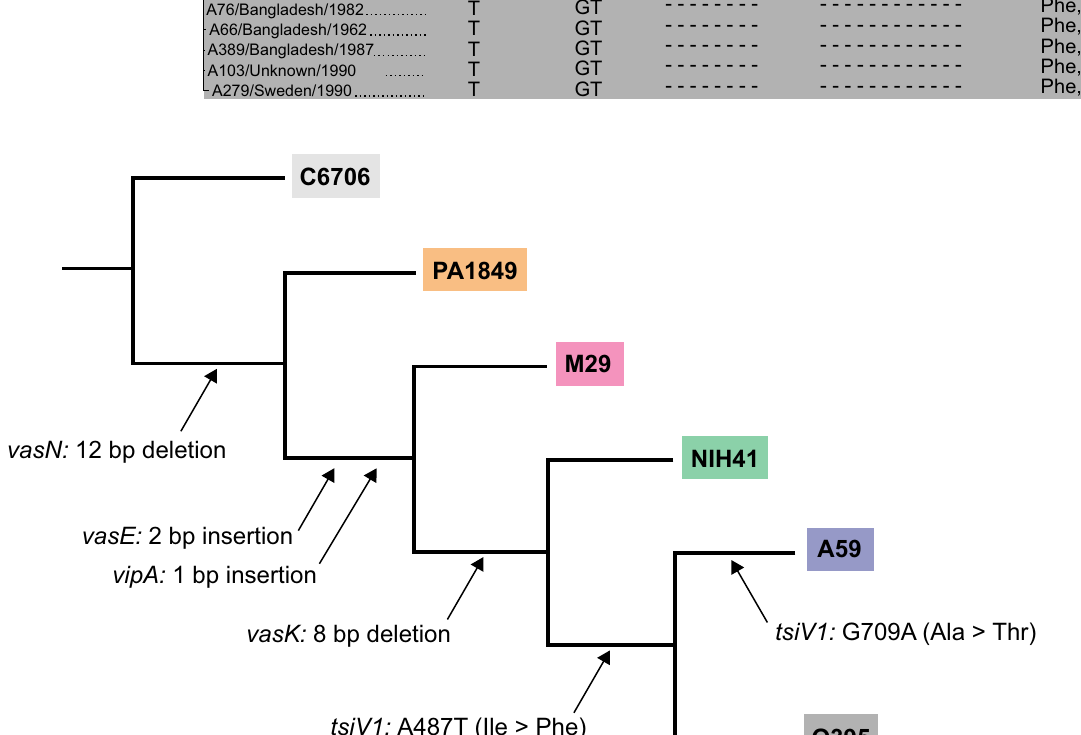
Fig. 4 Phylogeny of V. cholerae strains and their T6SS gene clusters. A Maximum likelihood tree based on core-genome SNP sites of indicated V. cholerae strains. Insertions, deletions and nucleotide substitutions are noted. Classical strains with the same mutations in the large cluster of the T6SS and TsiV1 are highlighted in the same colour. The horizontal bars indicate the mean. B Schematic representation of the sequential acquisition of T6SS mutations among representative classical V. cholerae strains. Arrows highlight the speci fi c changes to the T6SS gene